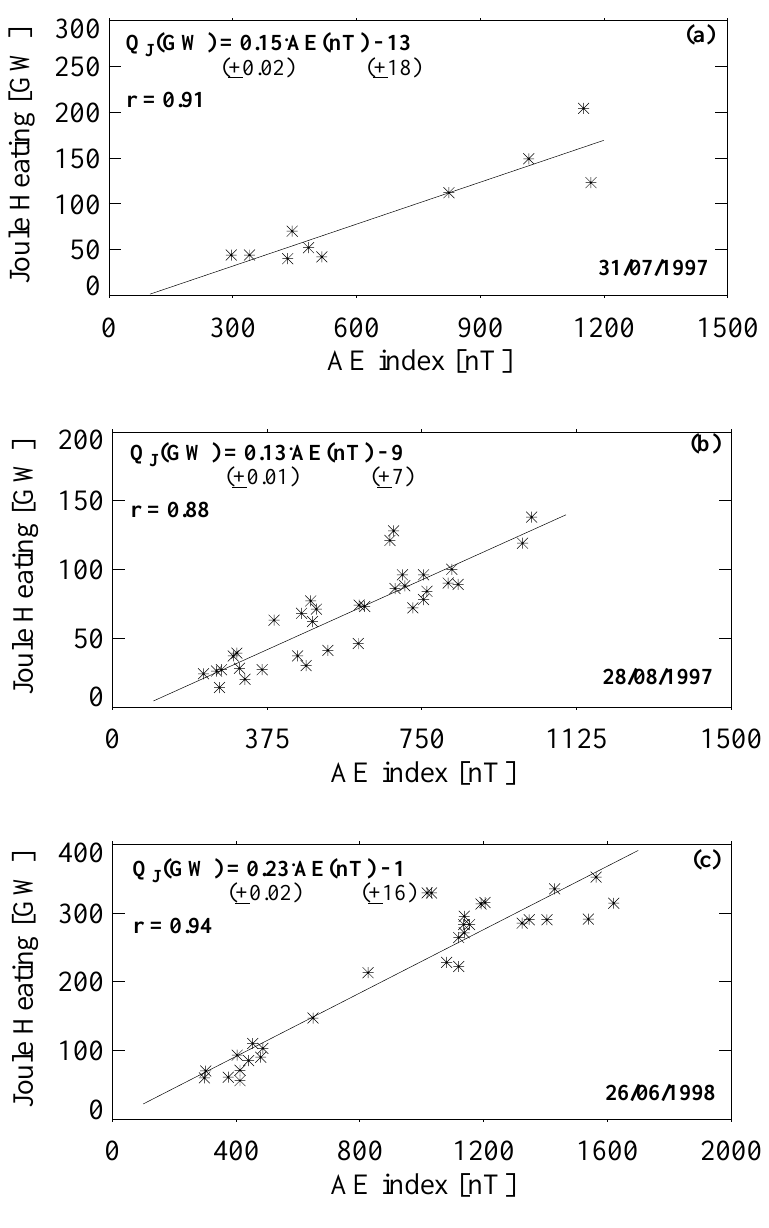
Fig. 17. The relationship between Joule heating and the AE index for the peri- ods with substorm activity occurring on (a) 31 July 1997 (b) 28 August 1997, and (c) 26 June 1998. Note that the PIXIE data have been included when deriving Joule heating presented here. The solid line in each plot represents the result from the linear regression an-